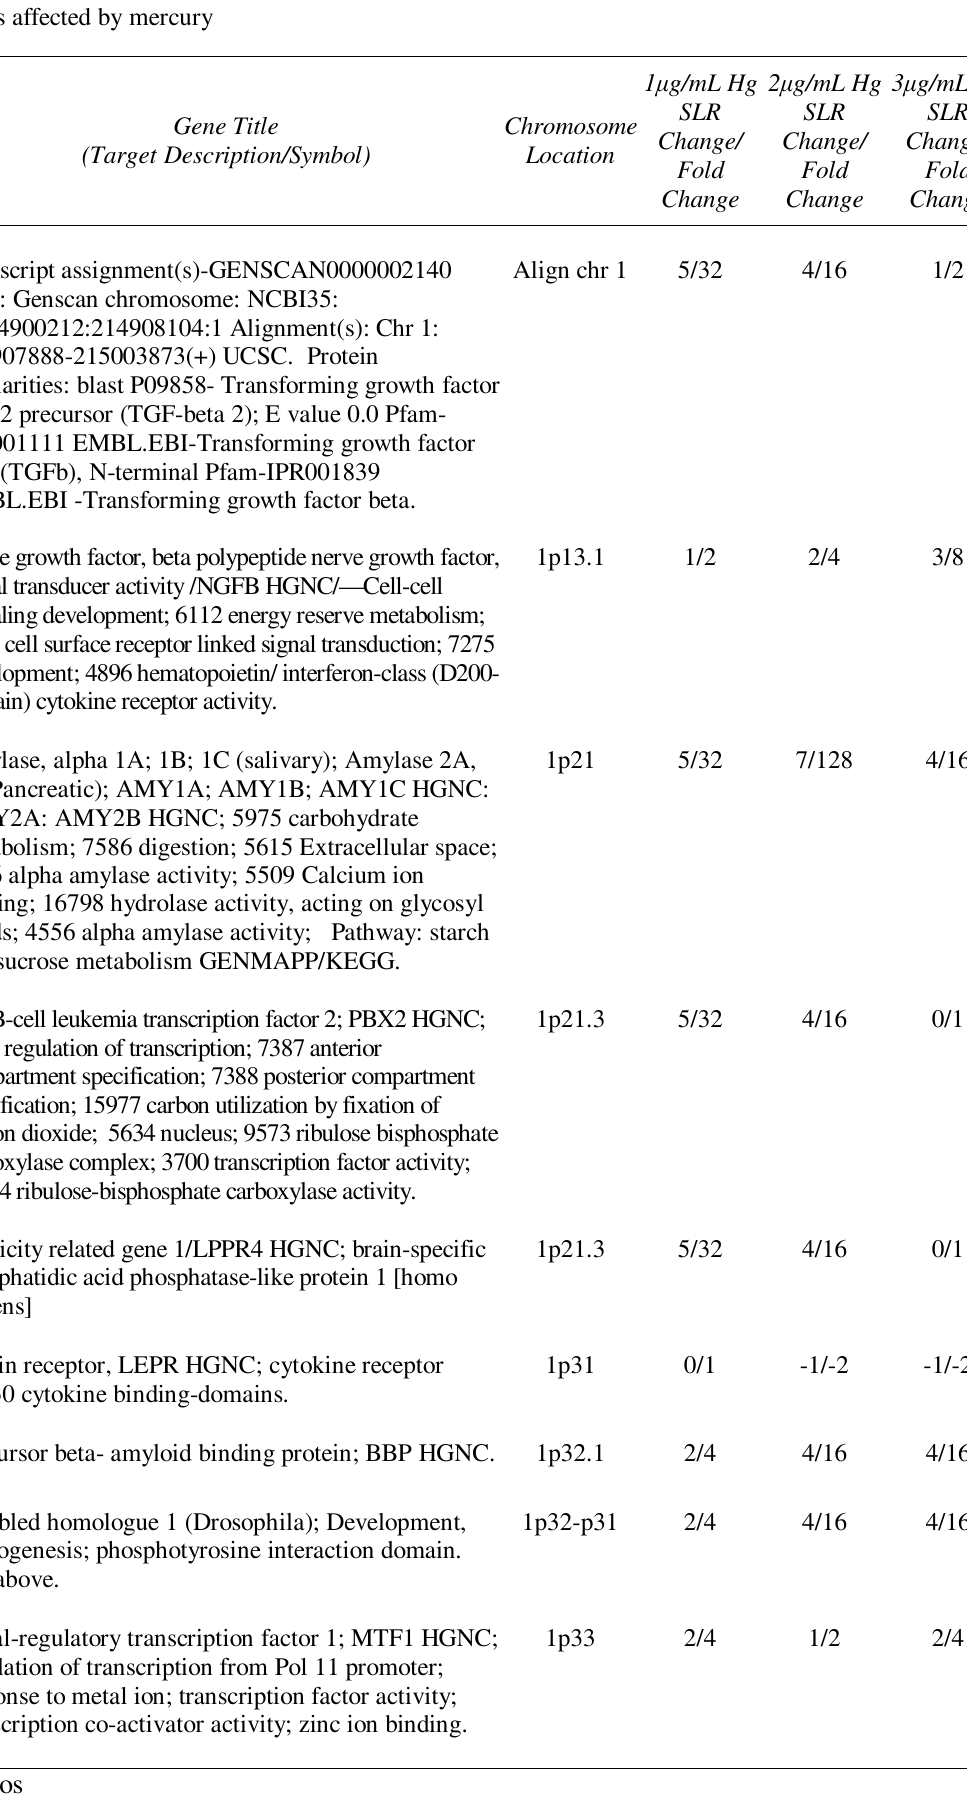
Table 1: Sample genes affected by mercury